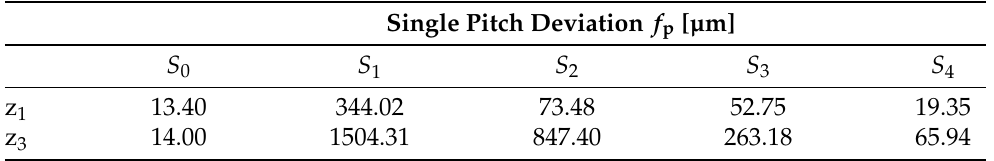
Table 2. Single pitch deviation f p of the two examined gears z 1 and z 3 .